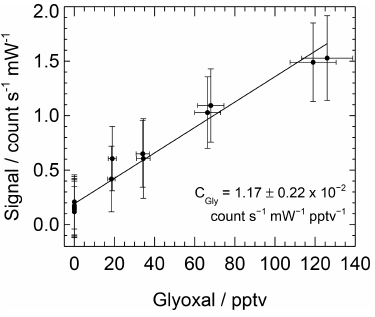
Figure 4. Typical calibration plot for glyoxal ob- tained during ORC 3 , giving C Gly = (1 . 17 ± 0 . 22) × 10 − 2 counts − 1 mW − 1 pptv − 1 .